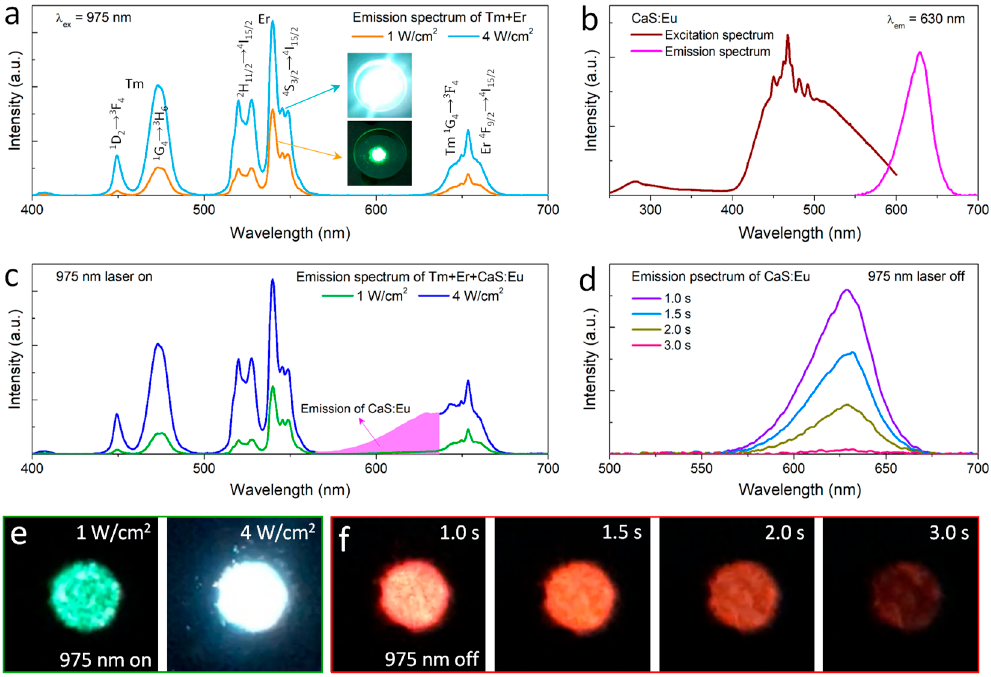
Figure 2. ( a ) UCL spectra of hybrids consisting of NaYF 4 :Yb/Tm and NaYF 4 :Yb/Er microrods. The insets show photographs of the solid hybrids under 975 nm excitation at various power densities. ( b ) Excitation spectrum of the commercially used CaS:Eu 2+ phosphors with 630 nm emission. ( c ) Emission spectra of the hybrids composed of NaYF 4 :Yb/Tm, NaYF 4 :Yb/Er and CaS:Eu 2+ under the 975 nm excitation at the different power densities. ( d ) Time-dependent emission intensities of hybrids at the 630 nm emission after the 975 nm laser is turned off. ( e , f ) Photos of solid hybrids when the 975 nm laser is on/off.